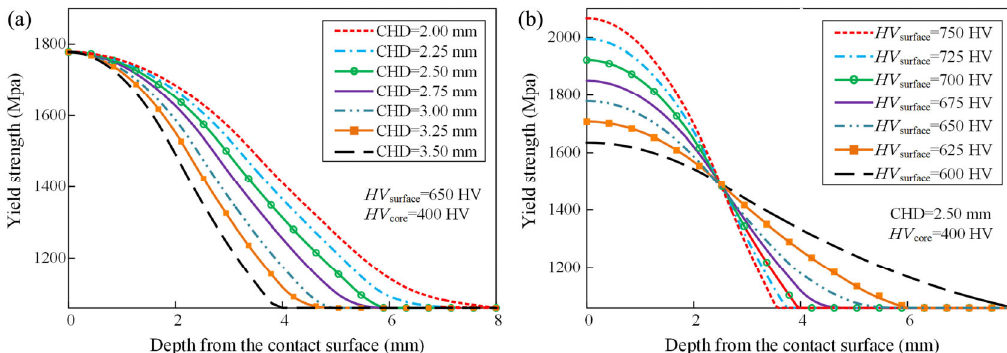
Fig. 6 Yield strength distribution with (a) different CHD values, and (b) surface hardness